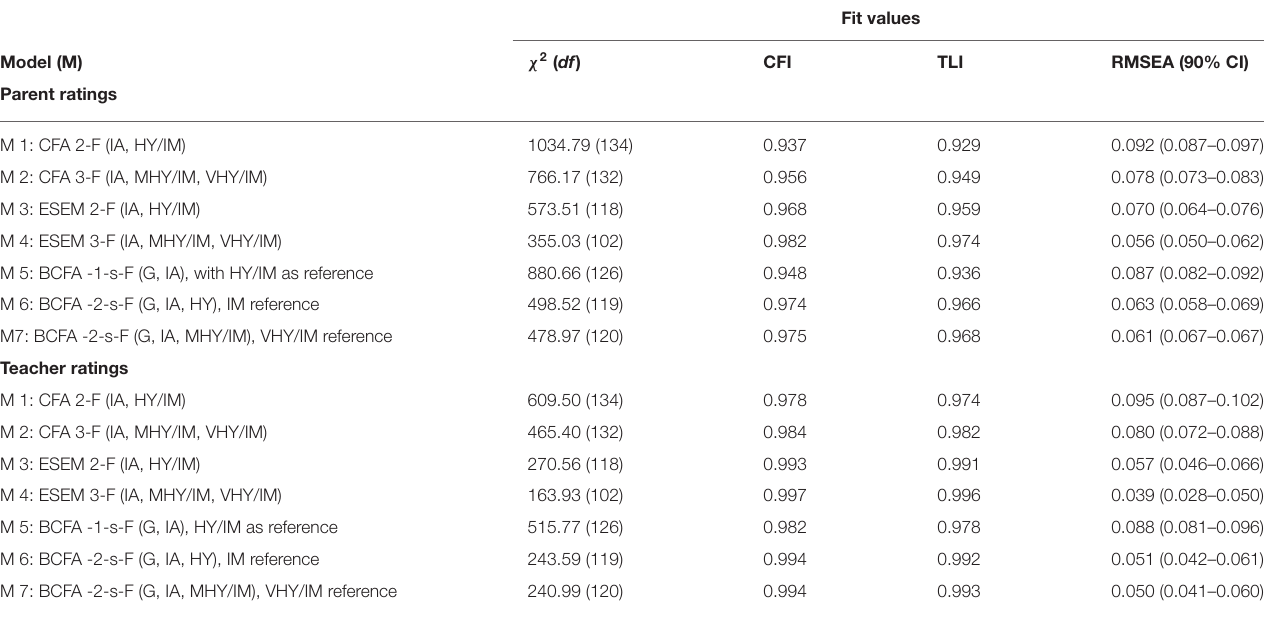
TABLE 1 | Fit of all the models tested in the